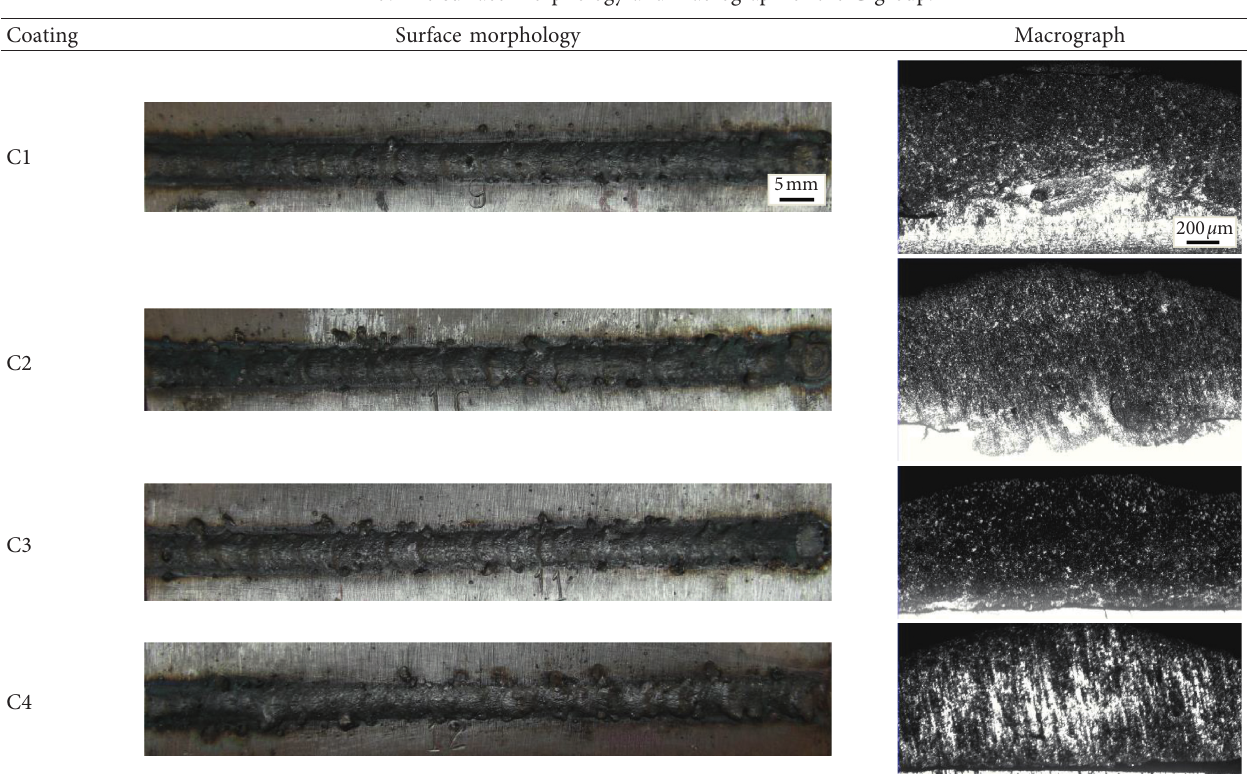
Table 5: The surface morphology and macrograph of the C group.